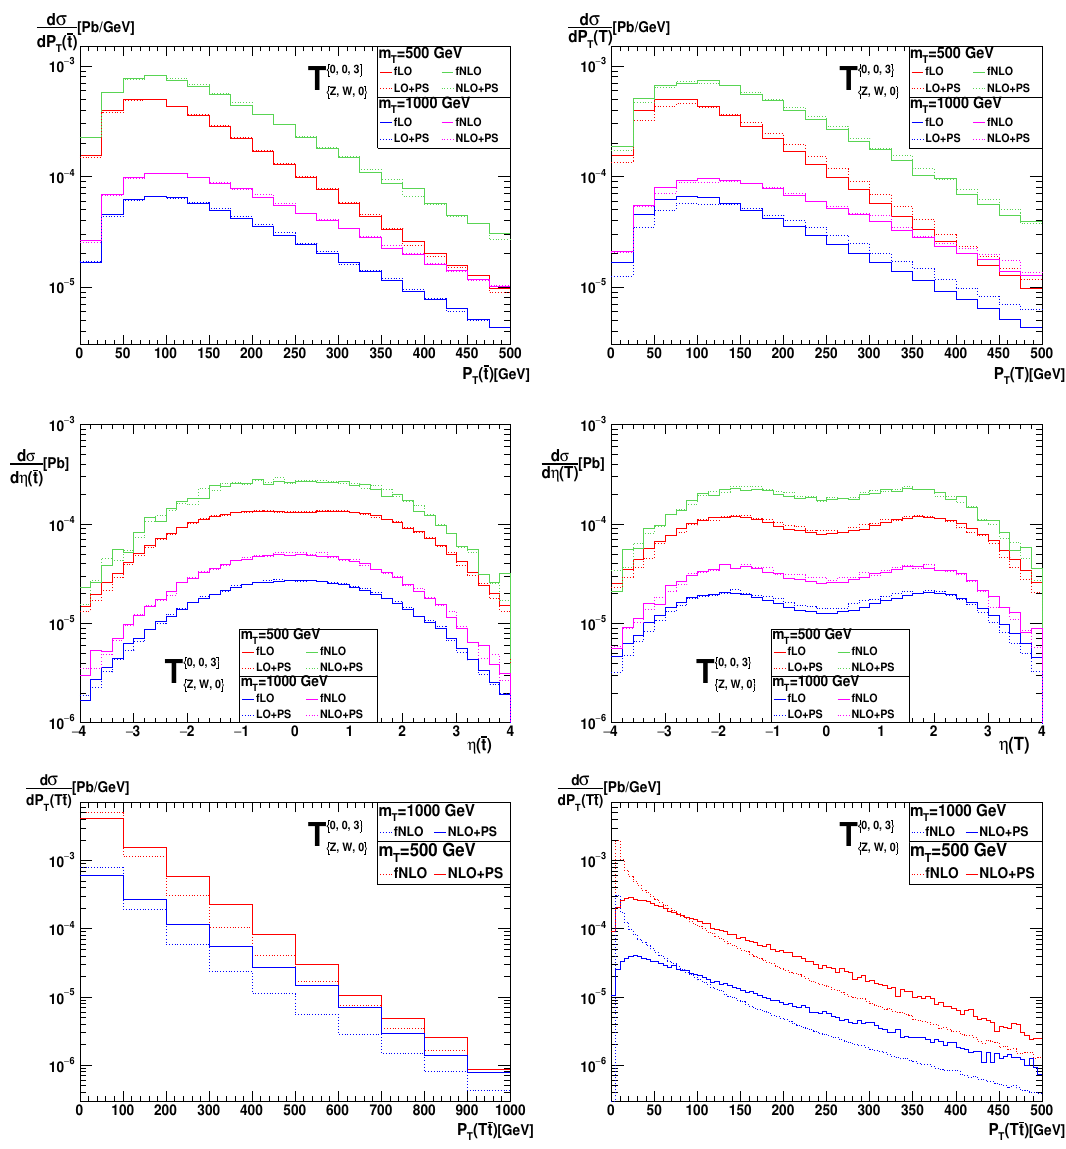
Figure 5 . Di(cid:11)erential distributions for the benchmark scenario T f 0 ; 0 ; 3 g